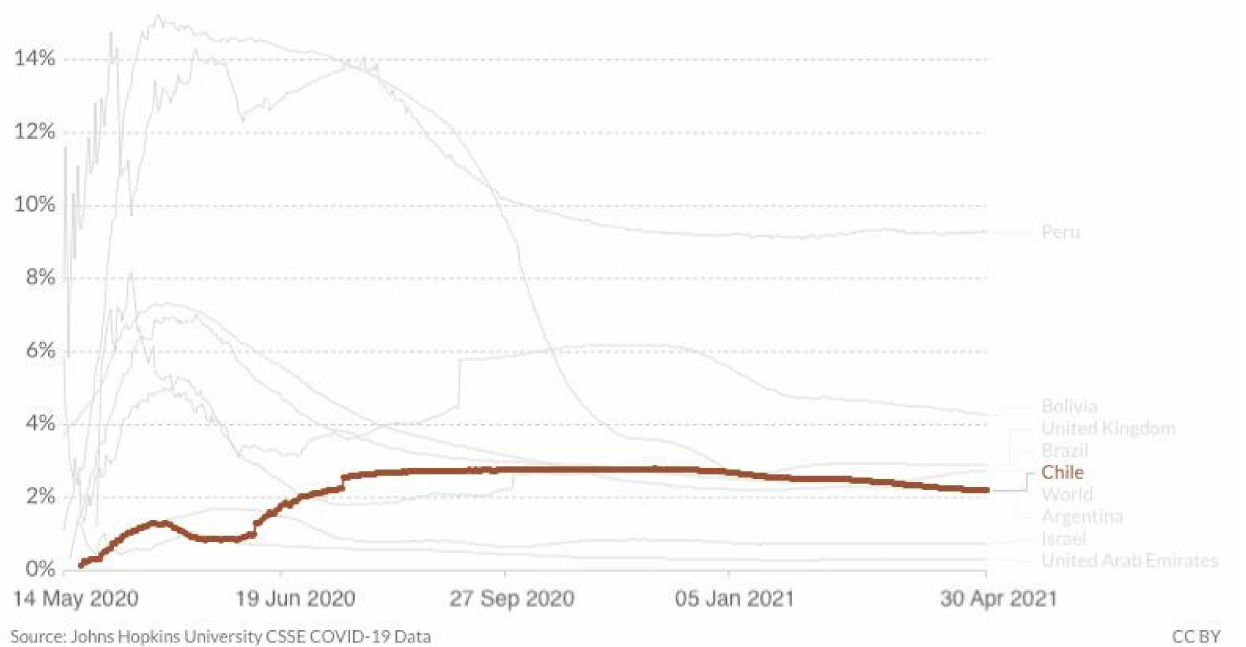
Figure 2. Number of daily new confirmed COVID-19 deaths per million people in Chile until 30 April 2021, including comparison with the region (Argentina, Brazil, Bolivia, Peru) and other leading vaccination nations (Israel, UAE, UK) www.ourworldindata.org (accessed on 1 May 2021).